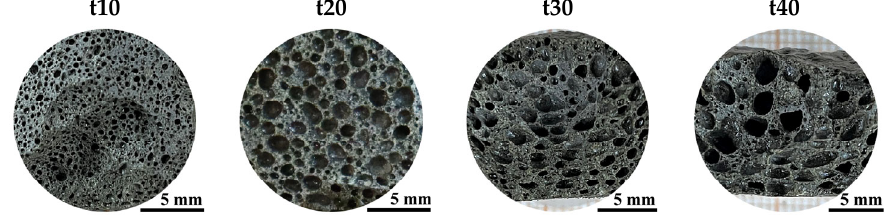
Figure 7. Cross ‐ sectional images of samples sintered at 1200 °C for different holding times. Figure 7. Cross-sectional images of samples sintered at 1200 ◦ C for different holding